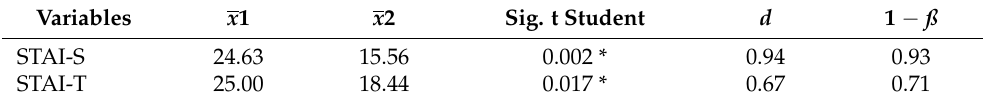
Table 7. Student’s t-test applied to anxiety parameters evaluated in ePSICONUT. Variables